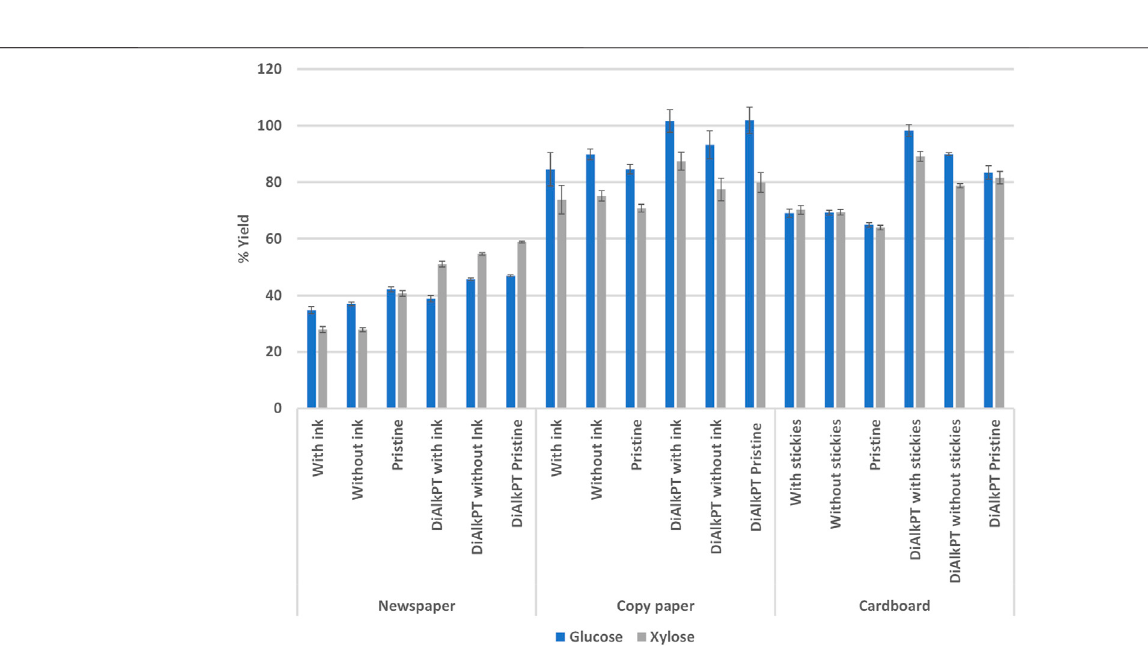
Frontiers in Energy Research |